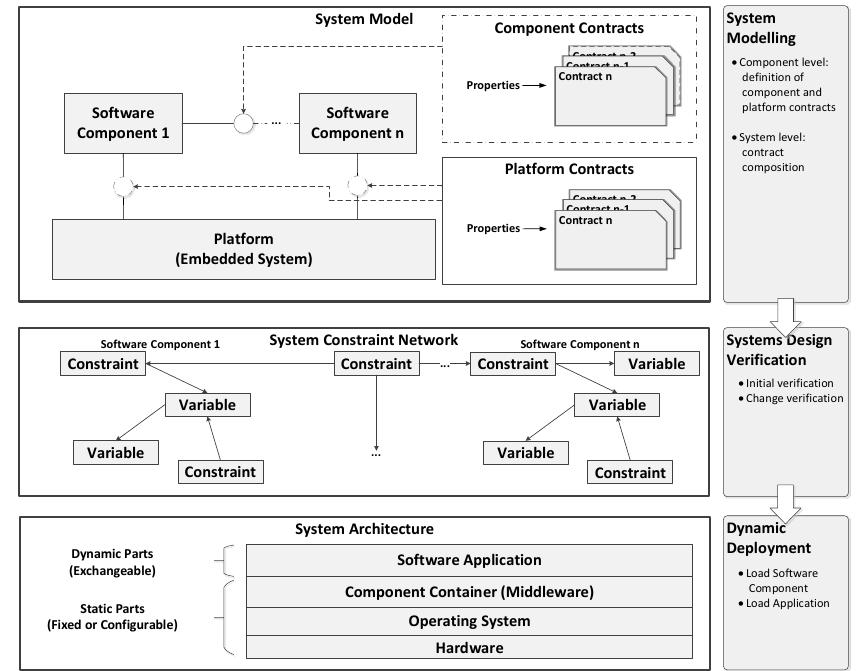
Fig. 2: Application of the proposed modelling and verification – workflow to verify an impact of changes on system integrity ( 13 ): system modelling using contracts (top), system design verification (middle) and dynamic deployment of software components